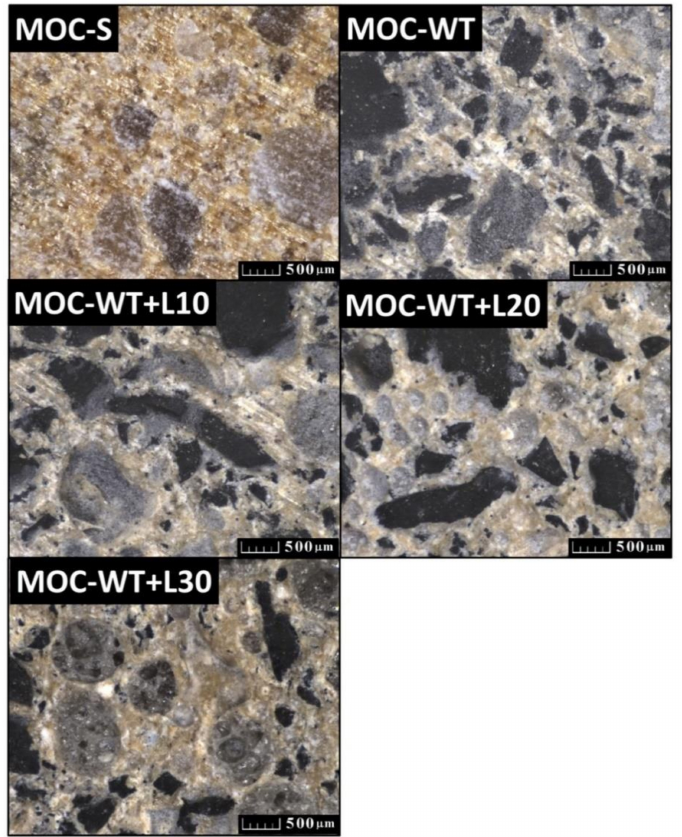
Figure 7. Photographs of composites acquired by optical microscopy (scale bar: 500 µ